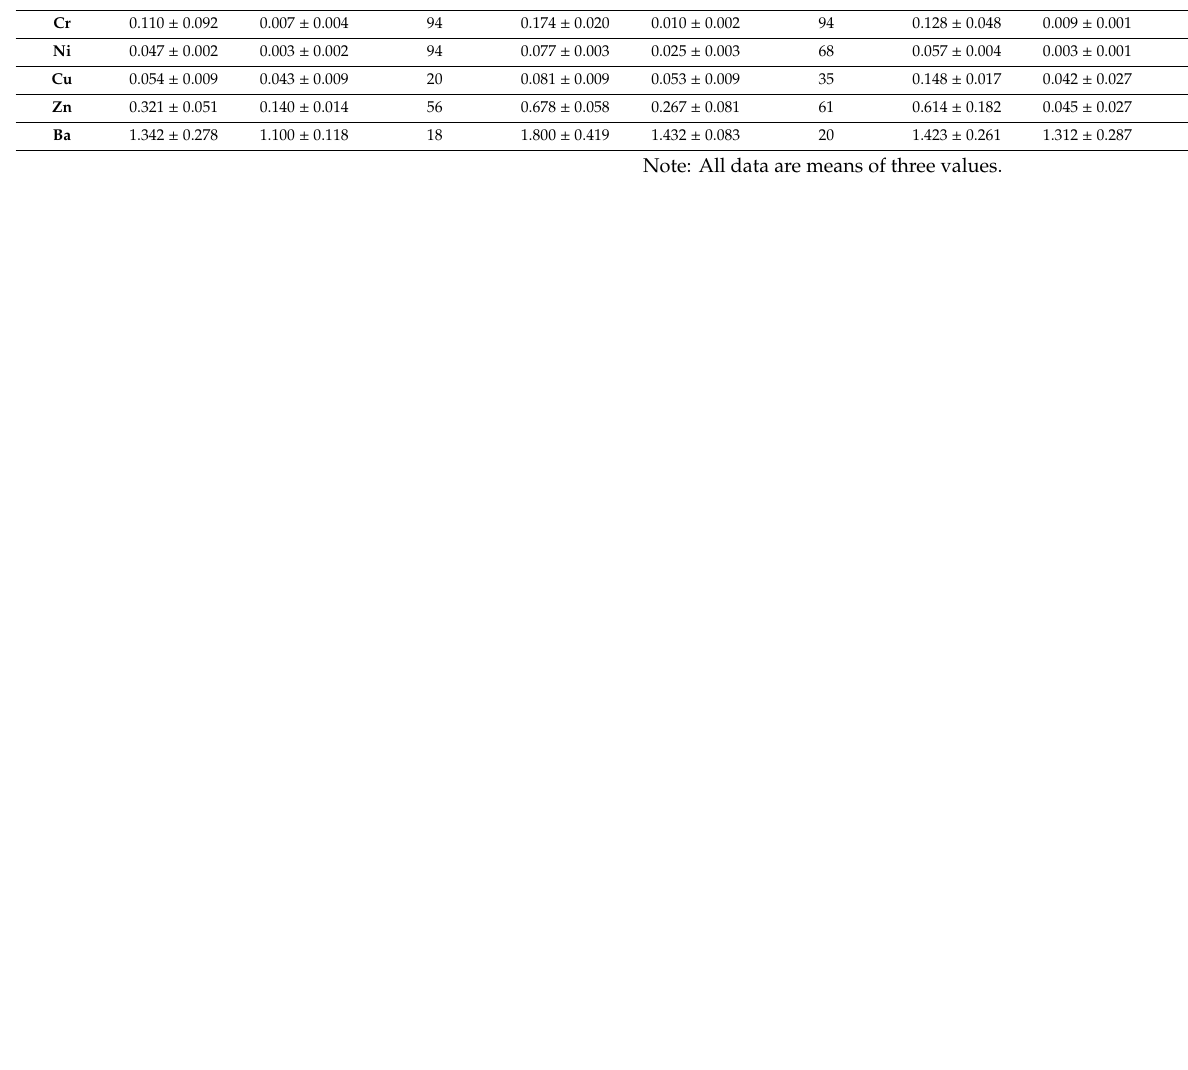
Table 4. Leaching concentrations of unfired and fired bricks containing 0.5%, 0.5%, 1%, 1.5%, and 2% CBs by mass for pH 9.2. Heavy Metals